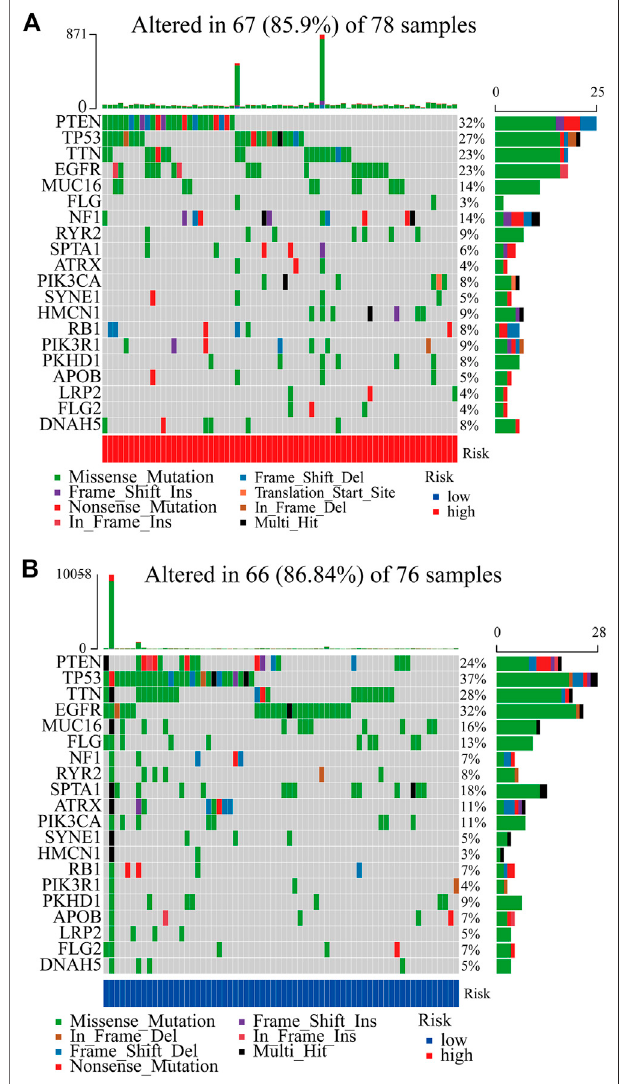
FIGURE6| Heatmap oftumor mutationburden ofthePRMintheTCGA database. (A) High-risk group. (B) Low-risk